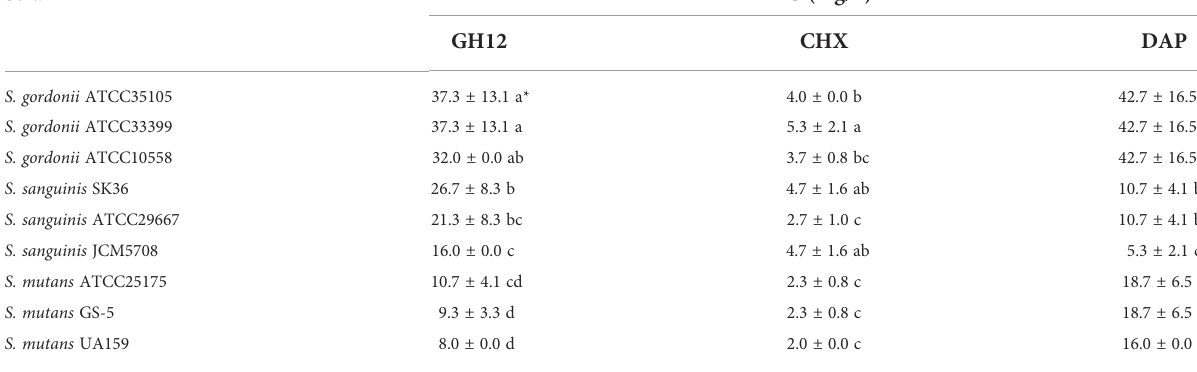
TABLE 1 MIC values of different species of streptococci against antimicrobial agents.